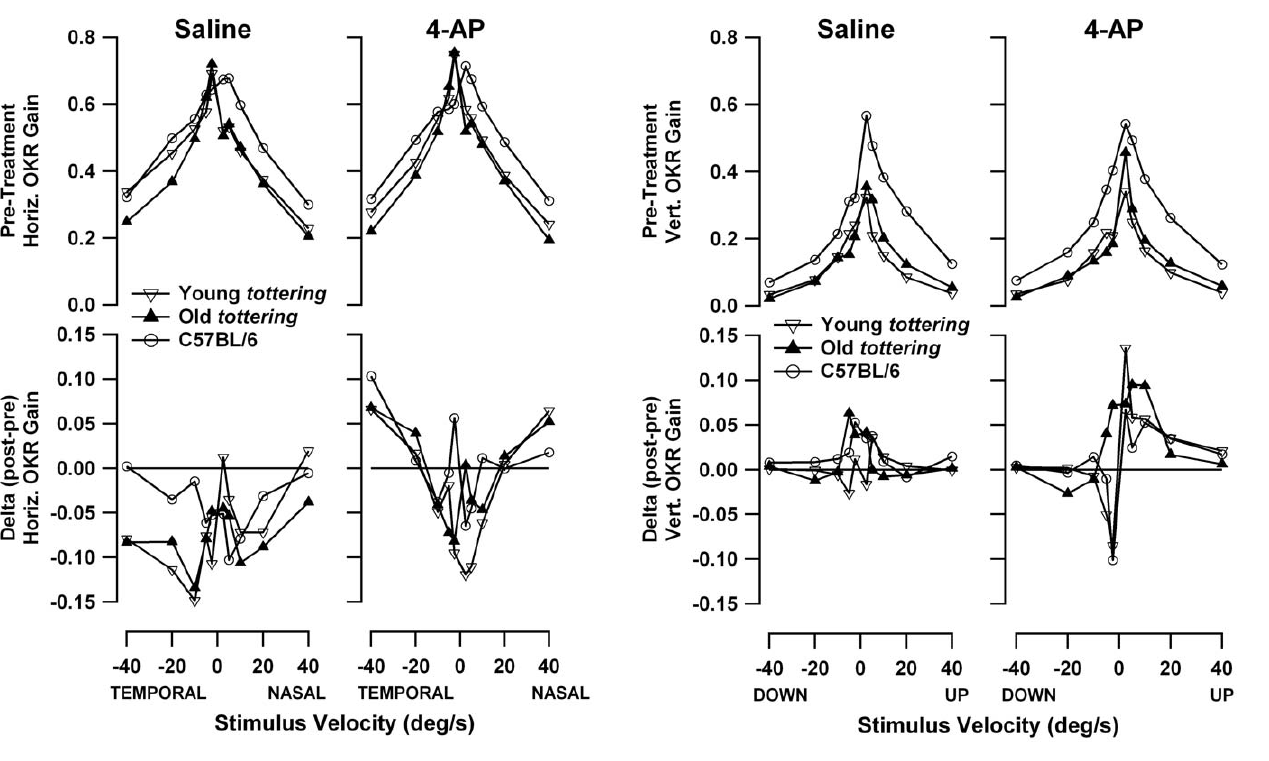
Figure 7. Speed tuning curves for roll OKR. Format is identical to Figure 6. 4-AP enhanced gains during upward stimulation for all cohorts. In contrast to the yaw OKR, habituation is not in evidence.